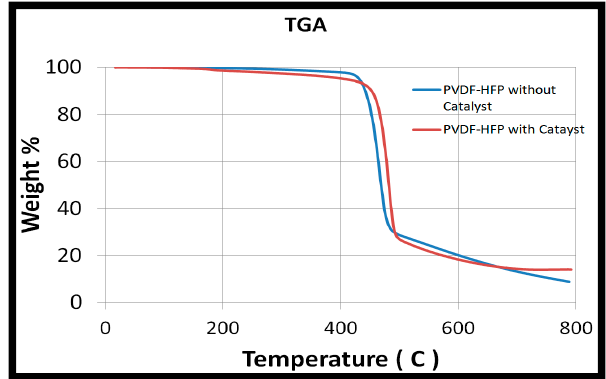
Figure 2. Thermogravimetric analyzer (TGA) analysis of PVDF-HFP nanofibers.